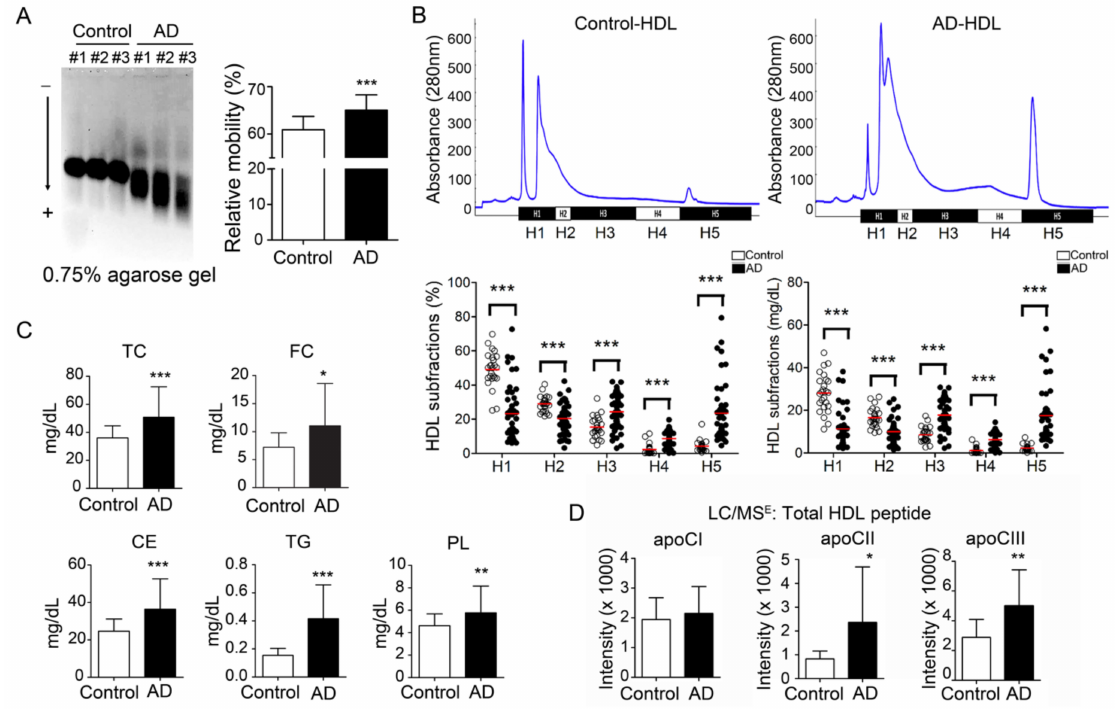
Figure 1. Electronegativity of high-density lipoprotein (HDL) was increased in Alzheimer’s disease (AD) patients. ( A ) HDL from AD patients show higher relative mobility than controls. ( B ) Representative patterns of HDL subfractionation by using fast-protein liquid chromatography. The lower panel shows that the percentage and quantity of H5 HDL were elevated in AD patients. Red line: mean value. ( C ) By using a colorimetric method, lipids were quantified. The lipid components were increased in HDL from AD patients. ( D ) Apolipoproteins were quantified by mass spectrometry. Results showed that apoCII and apoCIII were all increased. * p < 0.05, ** p < 0.01, *** p < 0.001, compared with controls and AD patients. Abbreviations. H1–H5: the five HDL subfractions divided according to electronegativity; TC: total cholesterol; FC: free cholesterol; CE: cholesteryl ester; TG: triglyceride; PL: phospholipids; ApoCI: apolipoprotein CI; ApoCII: apolipoprotein CII; ApoCIII: apolipoprotein